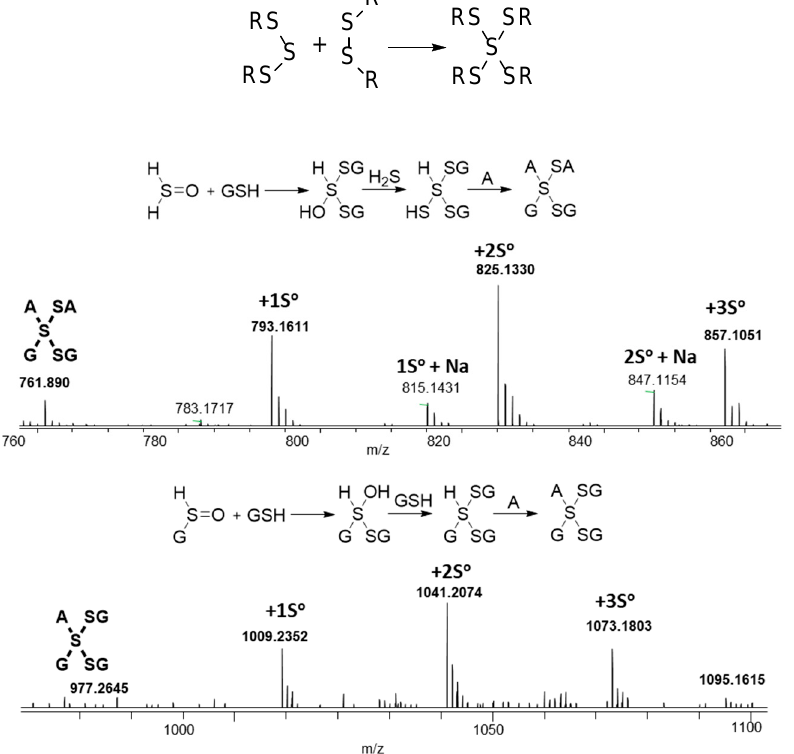
Figure 6. Mass spectra of sulfanedithiols derived from sulfinyls of (H 2 SO) and GS(O)H in the reaction of GSNO (1 mM) and Na 2 S (1 mM) in the presence of IA (5 mM) in iP buffer, pH 7.